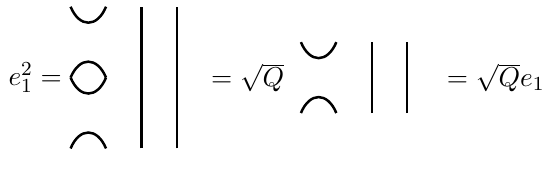
Figure 18 . Graphical interpretation of e 2